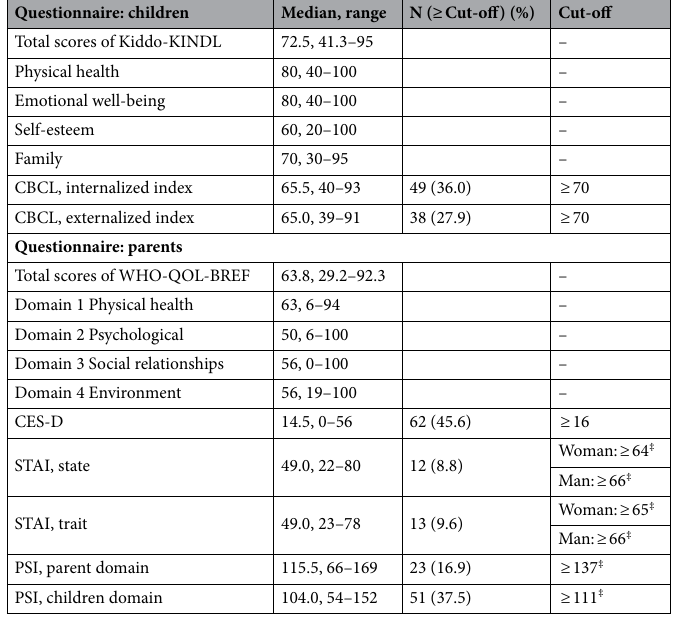
Table 2. Questionnaires administered children and their parents. N number, CBCL Child behavior checklist, WISC-IV Wechsler Intelligence Scale for Children–Fourth Edition, WHO world health organization, QOL quality of life, CES-D center for epidemiologic studies depression scale, STAI state-trait anxiety inventory, STI parenting stress index. ‡ Score was above the 95